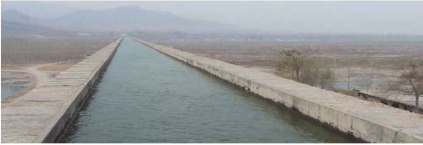
Figure 4: A single-pool canal in Yehe irrigation